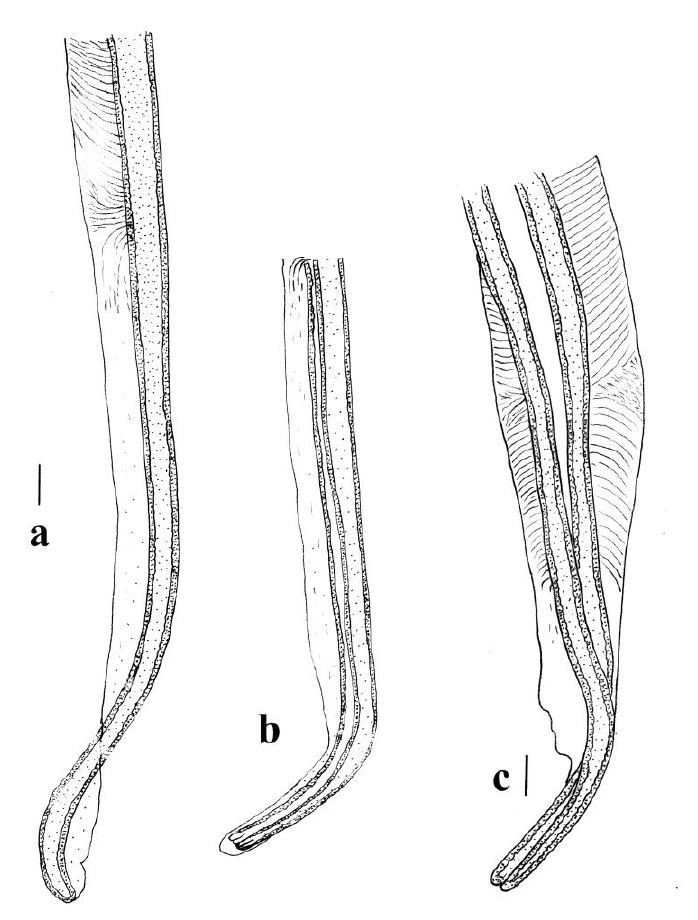
Figure 8. Comparative views of the spicule tips of Macropostrongyloides lasiorhini and Macropostrongyloides phascolomys n.sp. ( a ) Spicule tip of Macropostrongyloides lasiorhini , lateral view; ( b ) Spicule tip of Macropostrongyloides lasiorhini , oblique view; ( c ) Spicule tip of Macropostrongyloides phascolomys n. sp., lateral view. Scale-bars: 0.01mm.